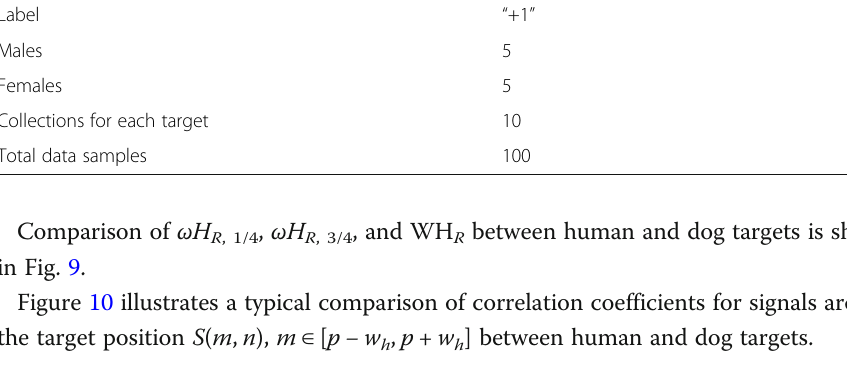
Table 2 Detailed description of the samples Label